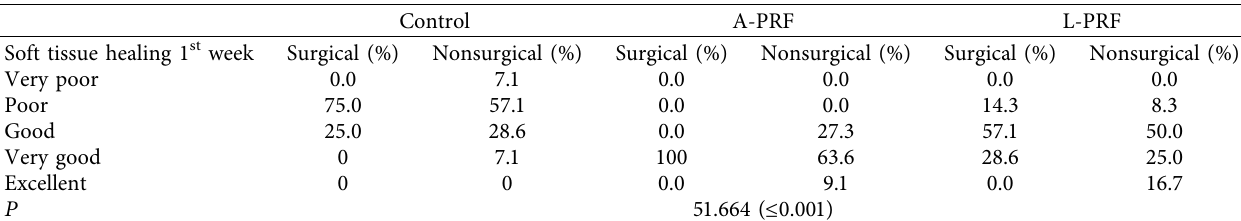
Table 3: Landry Wound Healing Indexes of each group on the first week after tooth extraction. Control A-PRF